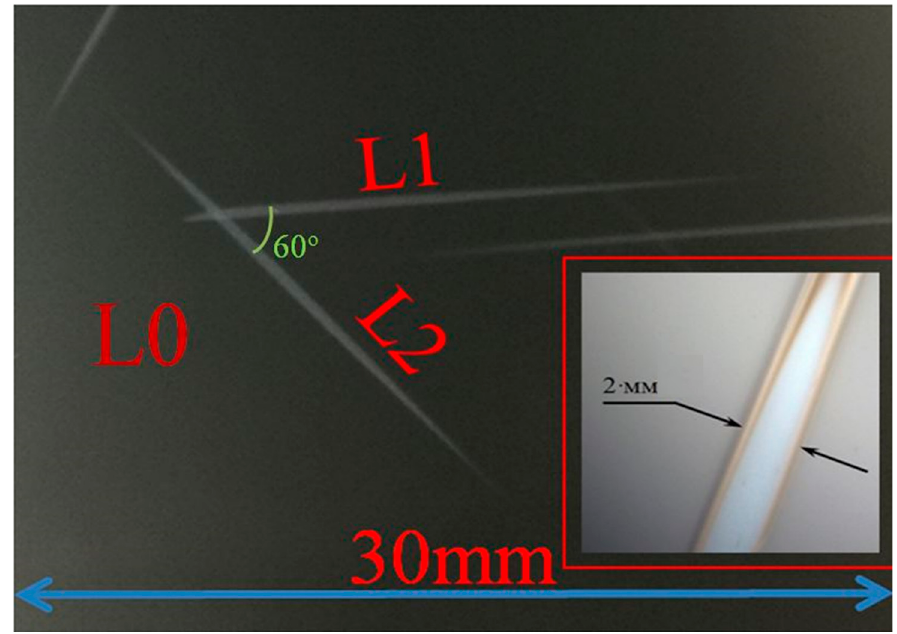
Figure 1. The optical image of trace from the impact of a rapid electron beam on the 10 nm thick CaF 2 film surface. L1—trace for case electron-beam irradiation directly during CaF 2 deposition and L2—electron-beam irradiation after the CaF 2 film formation. In the inset is an enlarged image of the electron-beam track. L0 is no irradiated area of sample with the 10 nm CaF 2 film thickness. The Raman spectra recorded outside of the irradiation region (L0), in the electron beam incidence area during the film growth (L1) (corresponds to the L1 line in Figure 1)